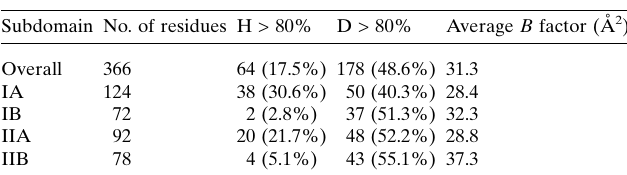
Table 3 The number of H/D-exchanged and unexchanged residues. The numbers in parentheses are percentages of the total number of residues.